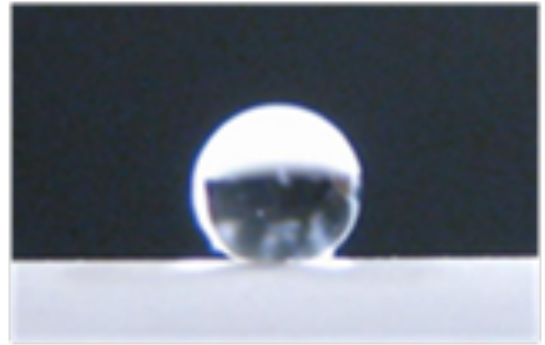
Figure 1. A water repellent characteristic of a superhydrophobic